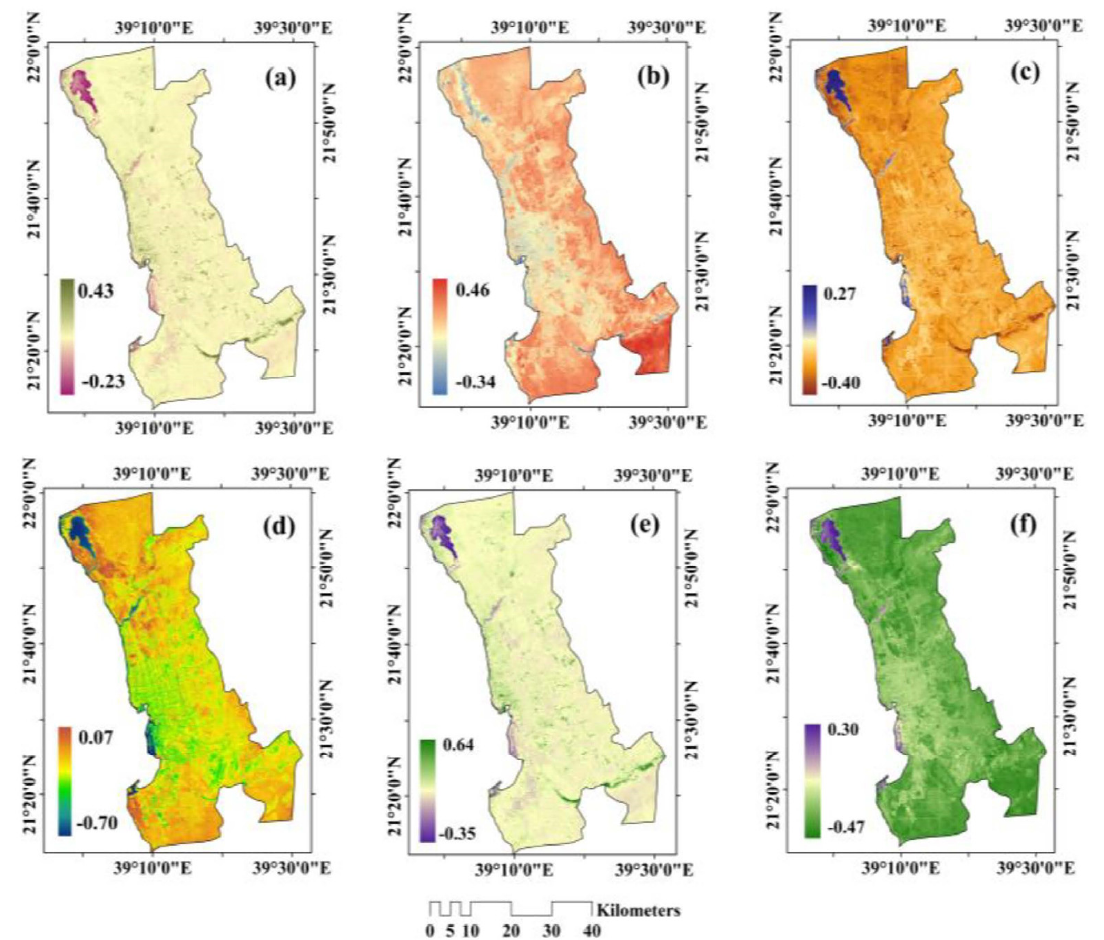
Figure 4. The distribution of biophysical indices in Jeddah (2021): ( a ) NDVI, ( b ) NDBI, ( c ) NDWI, ( d ) NDBaI, ( e ) SAVI, and ( f ) MNDWI (2021). Table 3. Descriptive statistics of the biophysical indices.